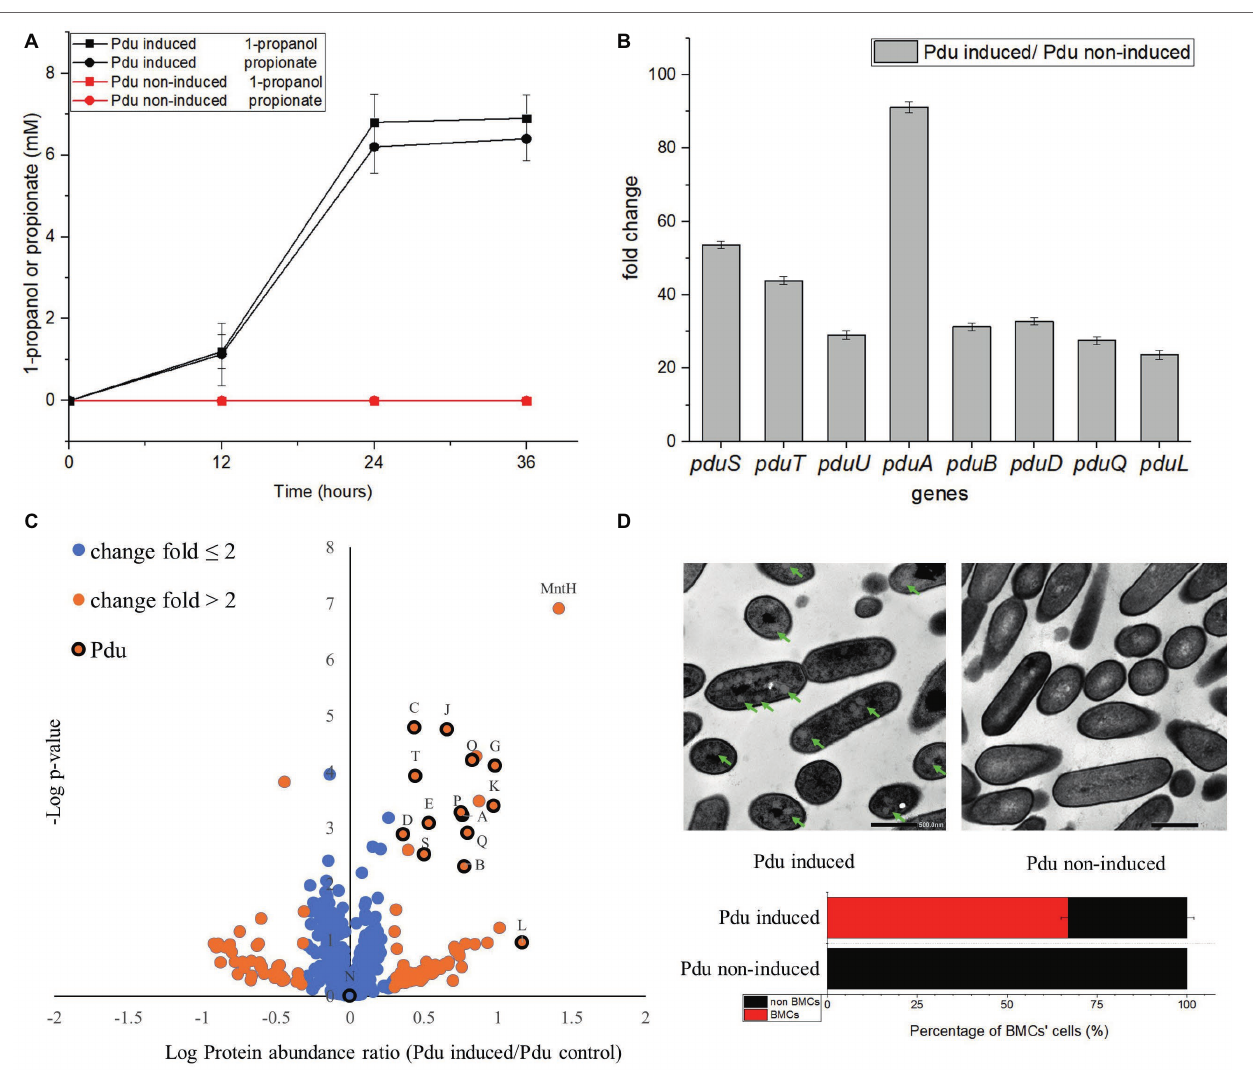
FIGURE 3 | Comparative analysis of product formation (A) , gene expression (B) , proteomics (C) , and presence of BMCs (D) in Pdu-induced and non-induced control cells. (A) Production of 1-propanol and propionate in L. monocytogenes EGDe Pdu-induced (in black) and non-induced control cells (in red). Results from three independent experiments with three technical repeats expressed as mean ± S.E.M. (B) Transcription of pduSTUABDQL genes. Fold change of selected genes in Pdu-induced cells versus non-induced control cells. Results from two independent experiments with three technical repeats expressed as mean ± S.E.M. (C) Proteomic volcano plot of Pdu-induced cells compared to non-induced control cells; fold change ≤ 2 in blue, fold change > 2 in orange, proteins in the Pdu cluster are indicated by their letter code and black circle. MntH, divalent metal cation transporter. (D) TEM visualization of BMCs in Pdu-induced (left) and non-induced control cells (right) and percentage of BMC-positive cells. Green arrows point to typical BMC structures, with the black scale bars representing 500